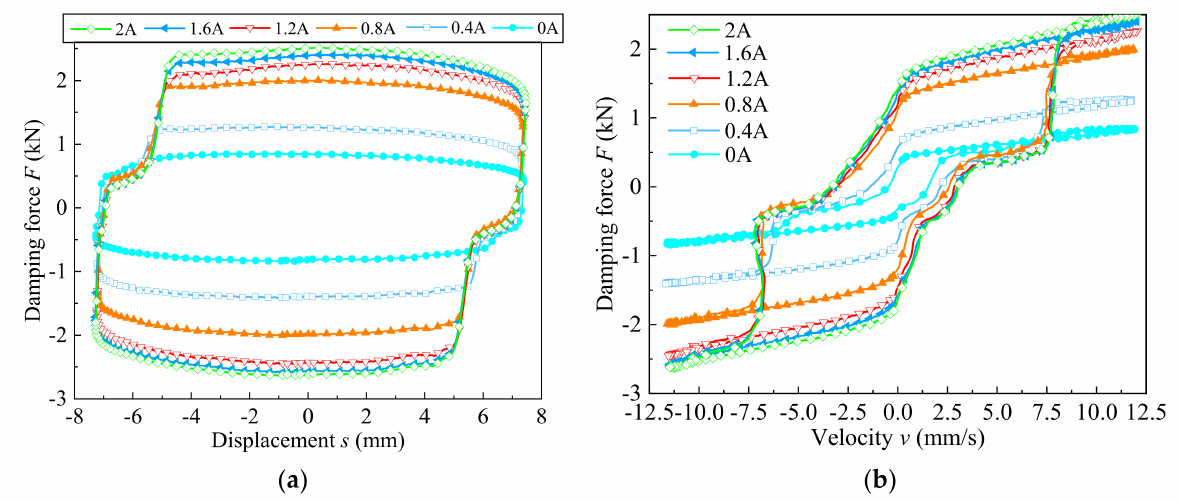
Figure 19. Damping performance of valve controlled cylinder system with radial damping gap of 1.0 mm: ( a ) force versus displacement, ( b ) force versus velocity.